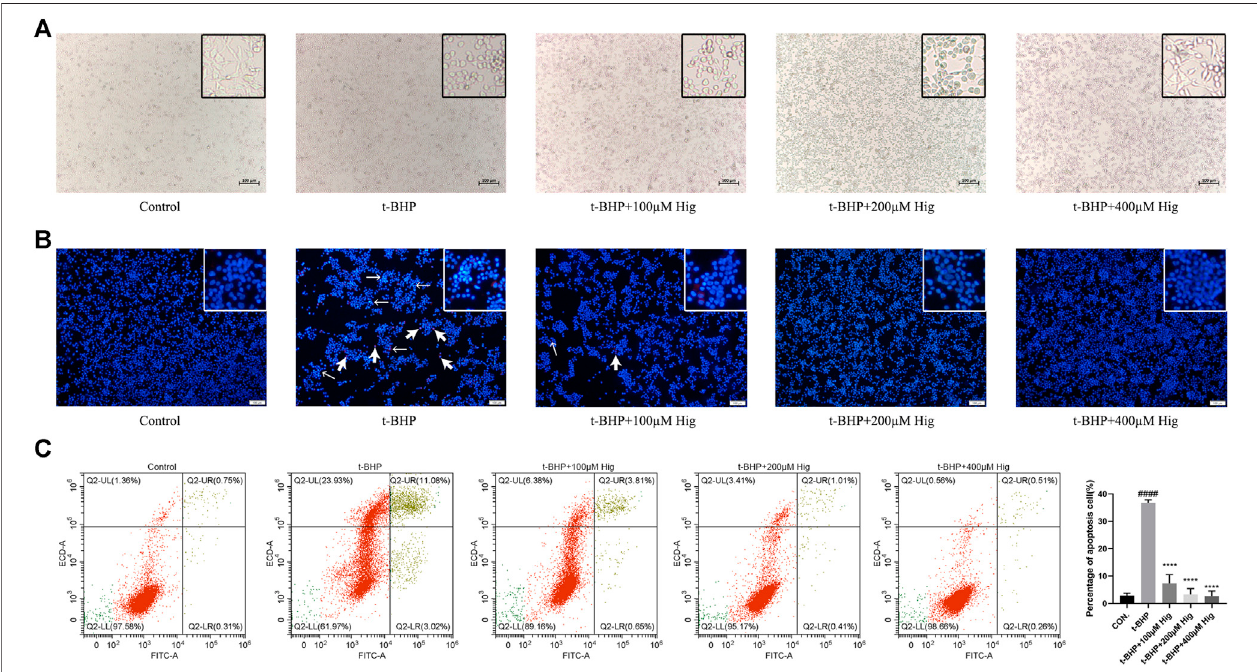
FIGURE 3 | Hig protected RSC96 against t-BHP-induced cell apoptosis. (A) The typical morphological images in different groups. (B) The stained RSC96 by Hoechst 33258/PI dye was observed under the microscope. The nucleus of RSC96 marked with strong blue (the thin black arrows) and red (the thick black arrows) fl uorescence represented cell apoptosis and necrosis, respectively. Scar bar (cid:2) 100 µm. (C) Annexin V-FITC/PI apoptosis kit analyzed the cell apoptosis via fl ow cytometerandthepercentage ofRSC96apoptosiswascalculatedfromtheadditionofQ2-UL,Q2-UR,andQ2-LR.Theresultsarepresentedasmean ± SEM, n (cid:2) 3. #### p < 0.0001 vs. the control group. **** p < 0.0001 vs. the t-BHP